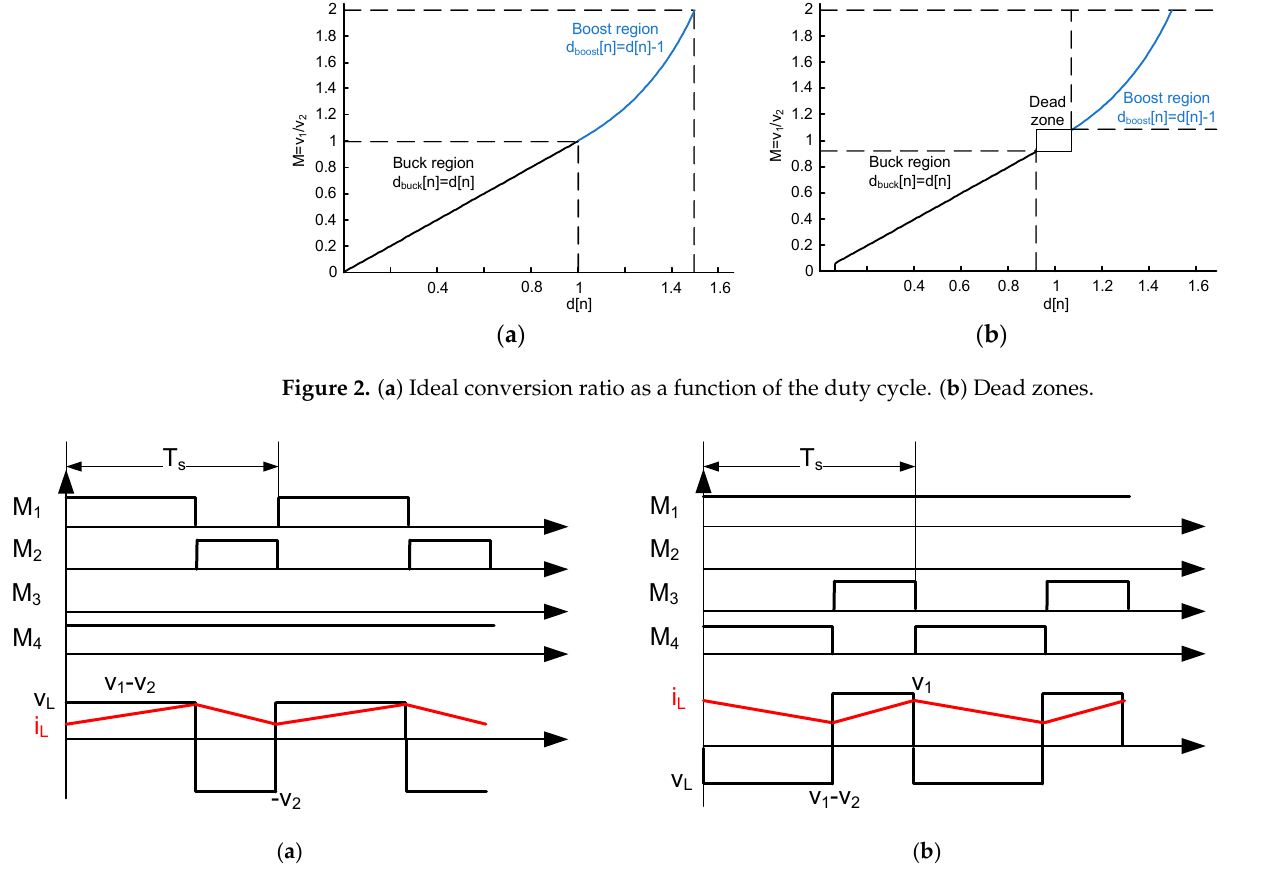
Figure 3. Main operation waveforms of the 4SBB in ( a ) Buck mode; ( b ) Boost mode.